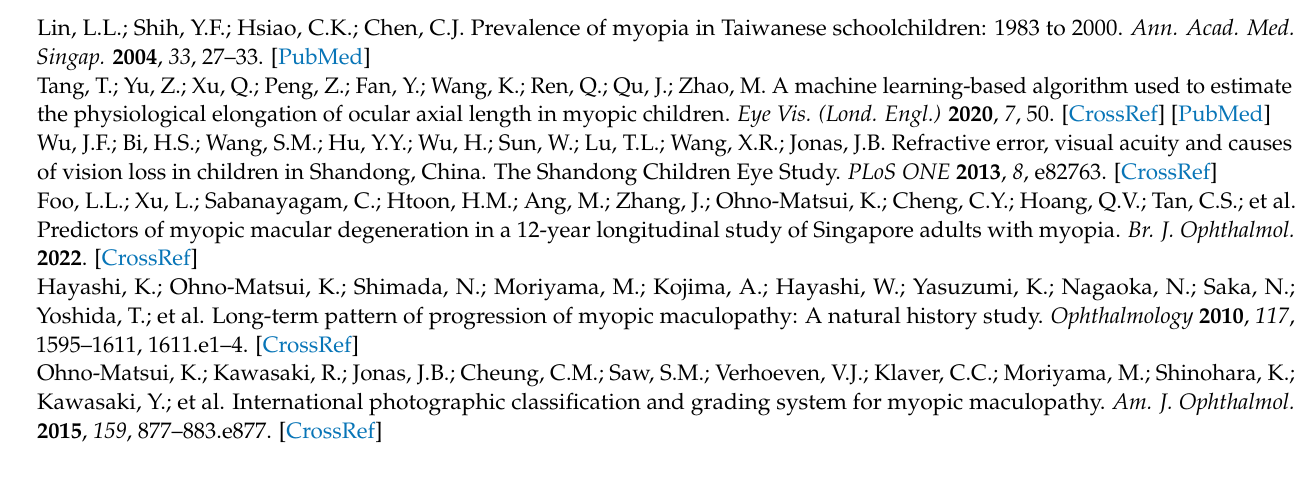
Figure S2: After running the R function roc. test, which performs the area under the ROC curve difference test, it was shown that the multivariate model differed from the univariate model, and there was no difference between the two multivariate